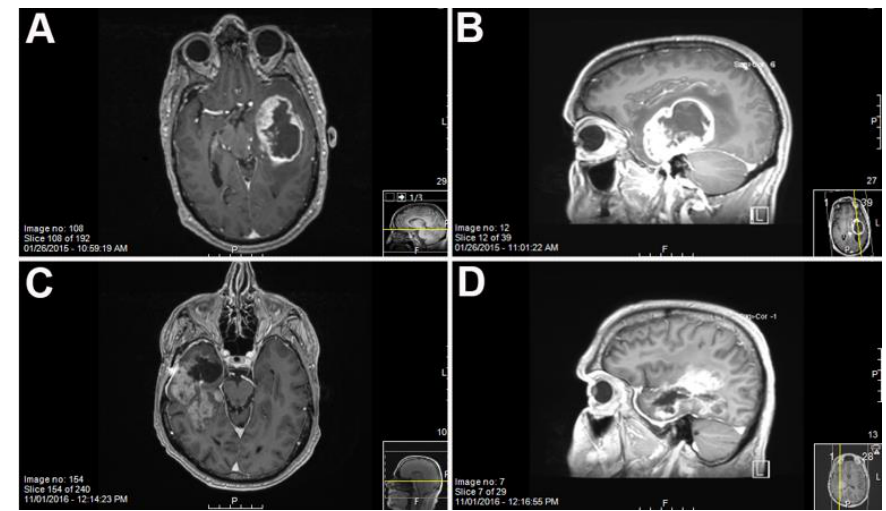
Figure 1. MRI of patient 2025, a 58 year old male (( A ) coronal and ( B ) sagittal) and patient 2409, a 57 year old male (( C ) coronal and ( D ) sagittal) with T1 weighted gadolinium contrast showing the location of the Glioblastoma multiforme (GBM) prior to resection.